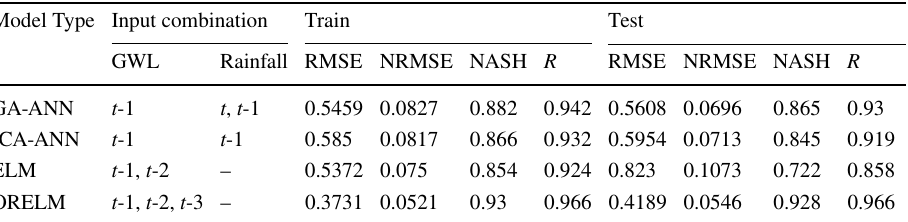
Fig. 6 Graphic representation of scatter points around the Y = X line and the squared value of the correlation coefficient for choosing the best artificial intel- ligence model in the modeling test